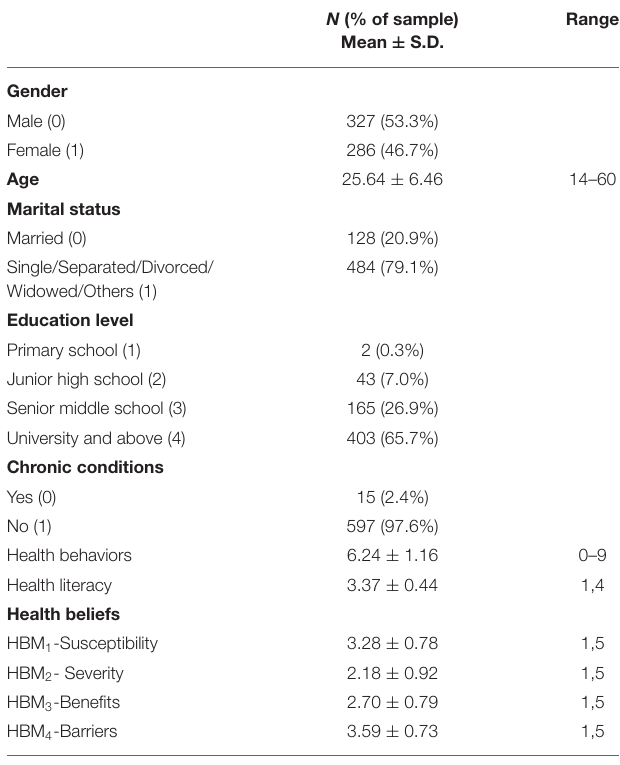
TABLE 2 | The descriptive results of the participants ( N = 613).